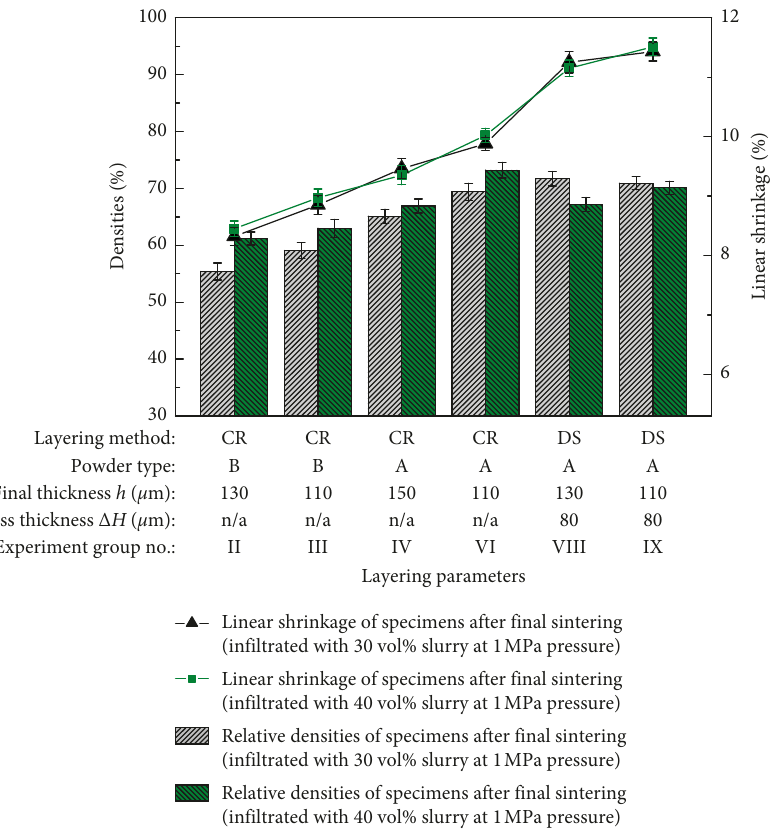
Figure 18: Variations of final-sintered specimens’ linear shrinkages along with their final densities.